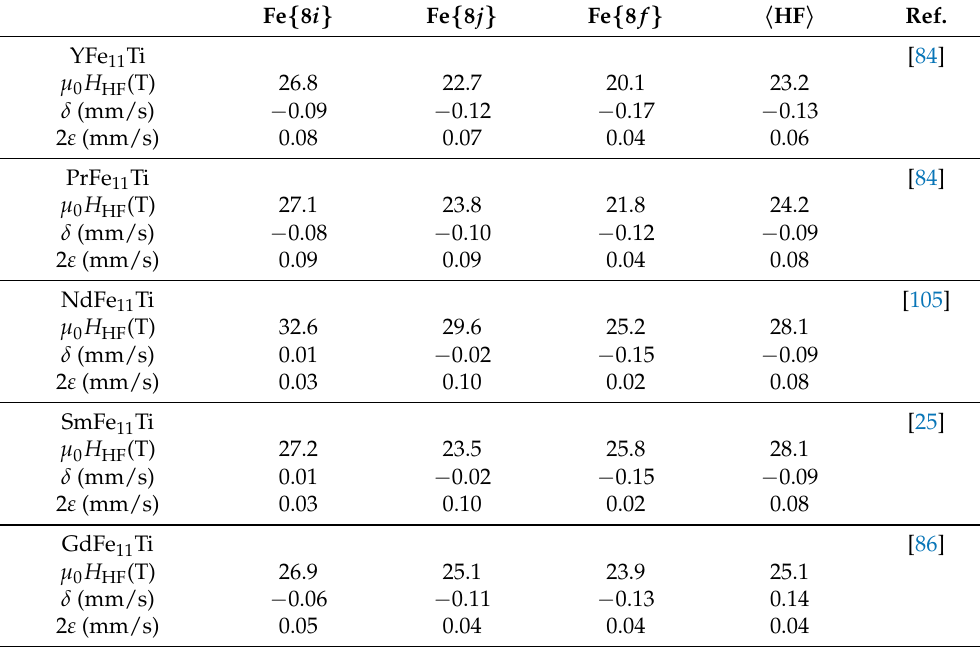
Table 8. Room temperature Mössbauer hyperfine parameters for R Fe 12 − x M x : Hyperfine field ( H HF ), isomer shift ( δ ) and quadrupole interaction (2 ε ). (cid:104) HF (cid:105) denotes the average of the hyperfine